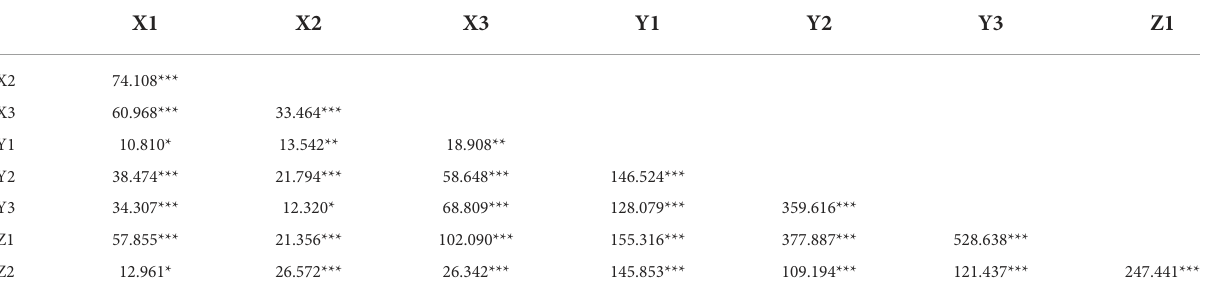
TABLE 2 Correlation analysis of insurance awareness, satisfaction, and trust.